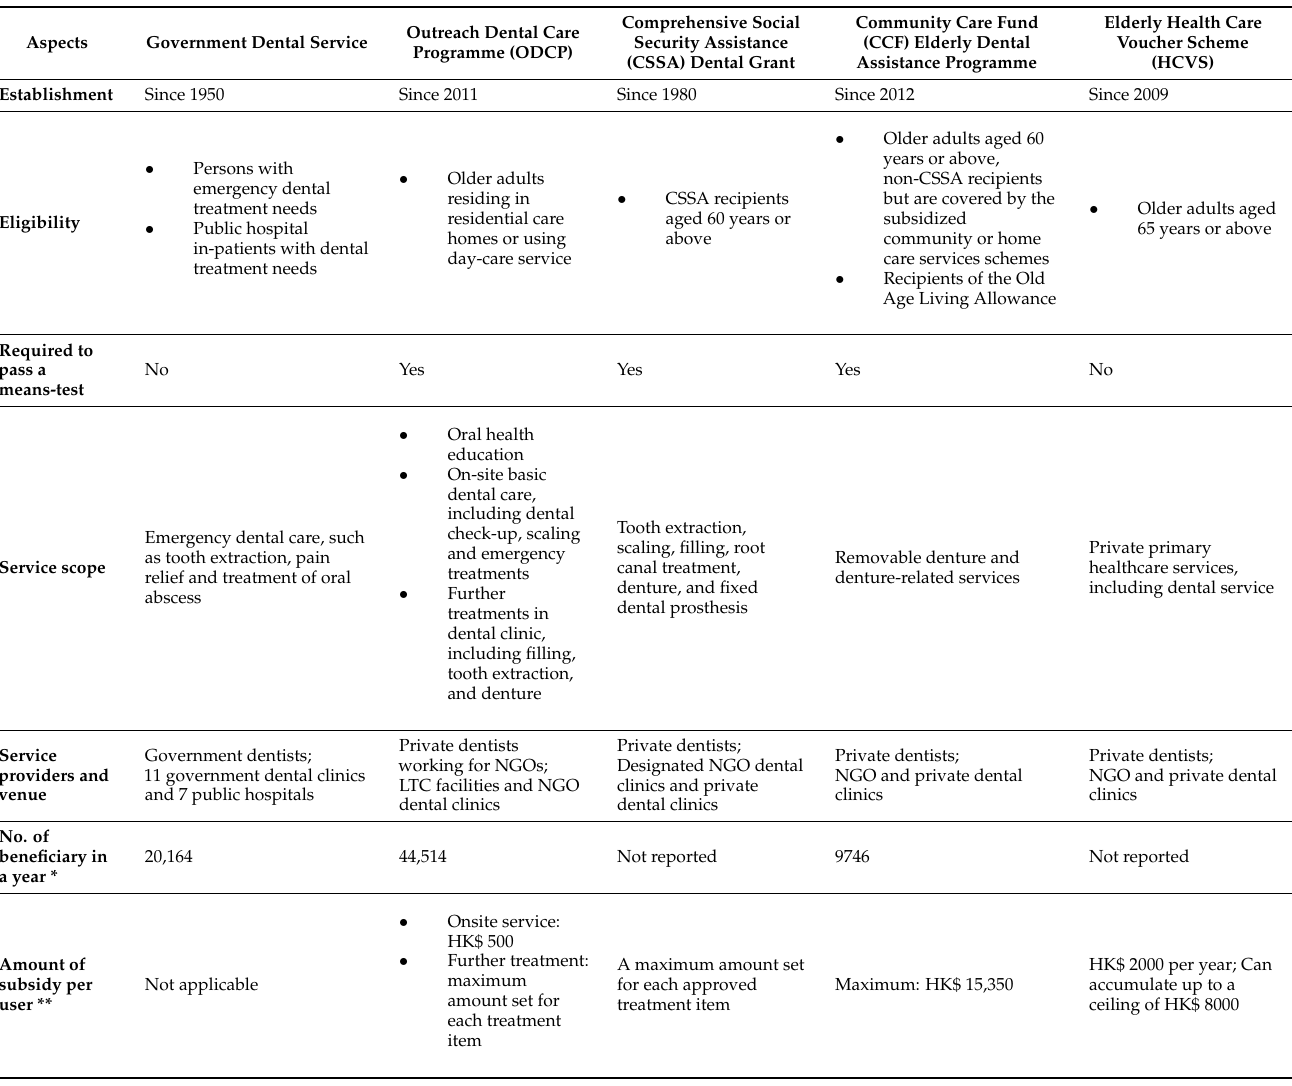
Table 1. Summary of public-funded dental care services for the older adults in Hong